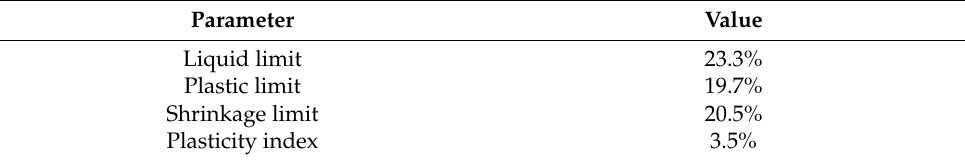
Table 4. Atterberg limits of the tailing used.